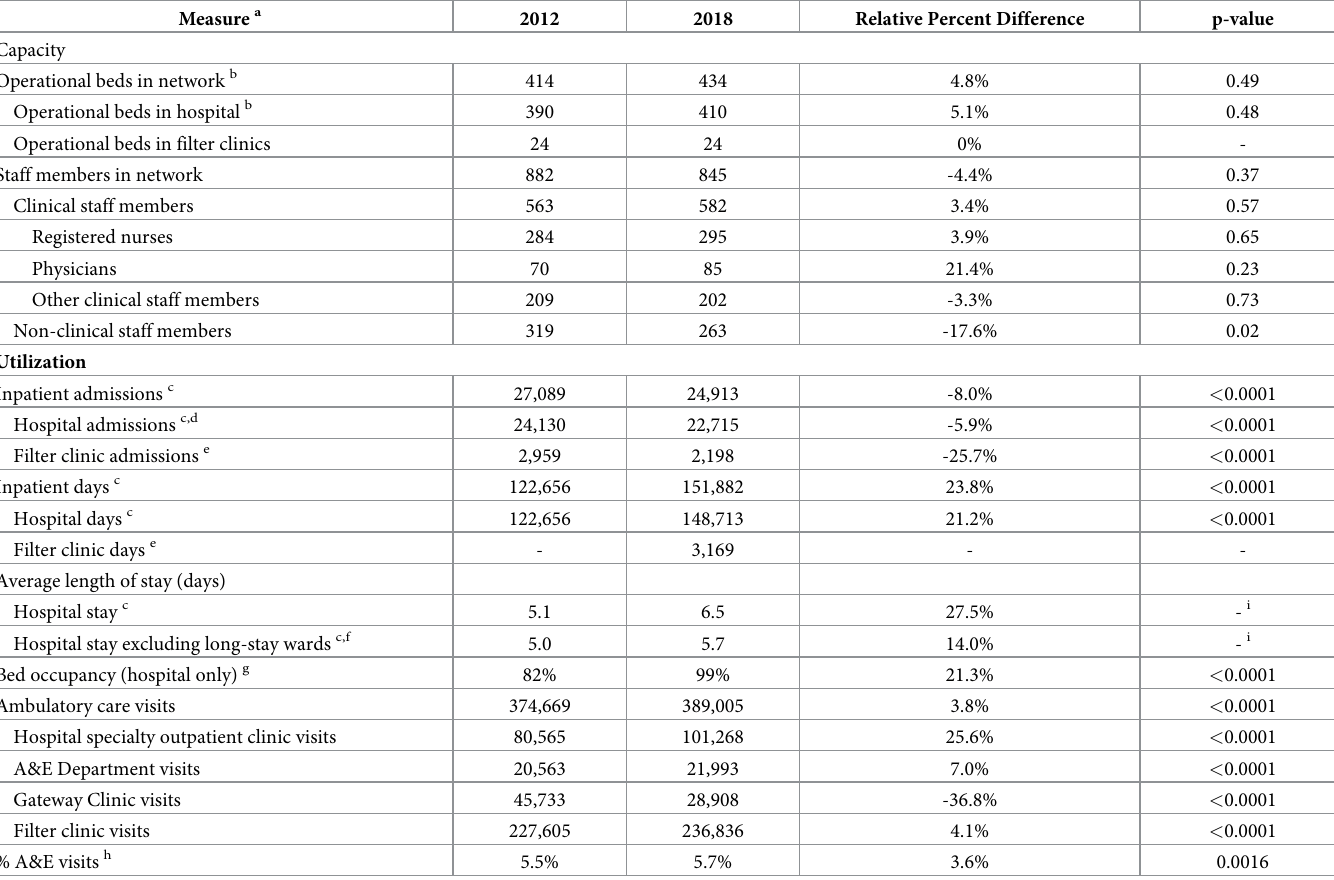
Table 1. Capacity and Utilization Measures at Queen ‘Mamohato Memorial Hospital Integrated Network Managed by a Public-Private Partnership in 2012 and 2018. Measure